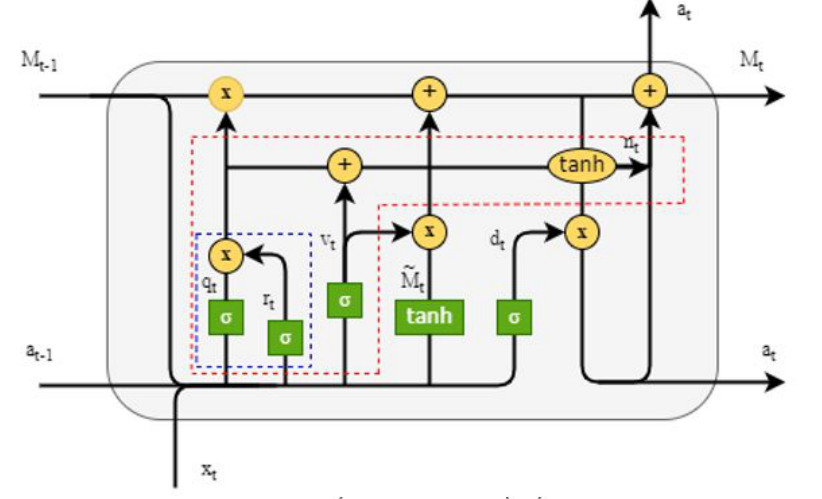
Figure 4. GLVP model for viewport estimation